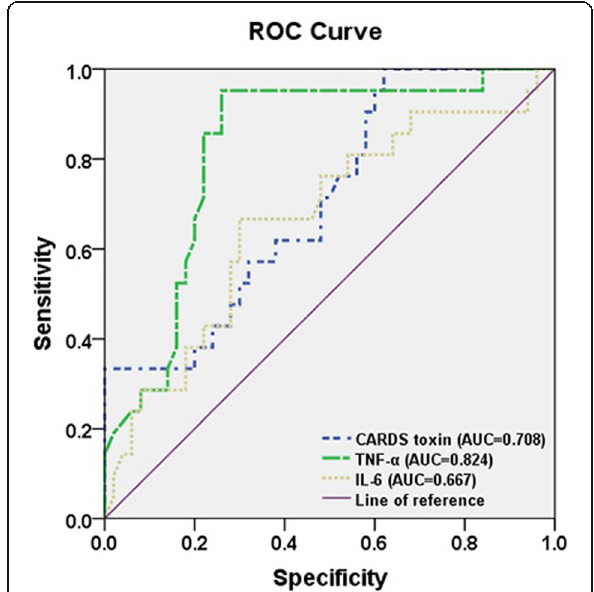
Fig. 3 Diagnostic values of CARDS toxin, TNF- α , and IL-6 in children with RMPP. TNF- α had better diagnostic ability for differentiation of